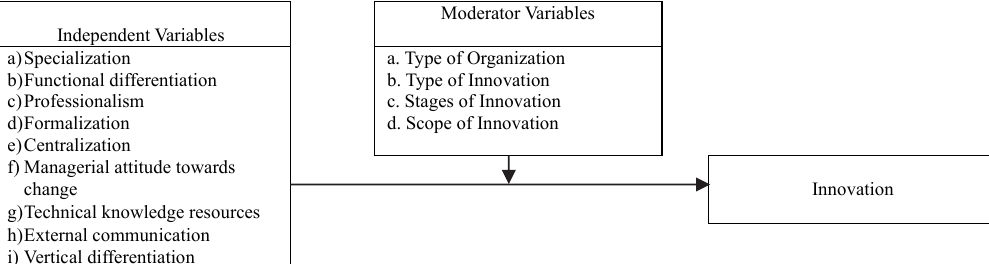
Fig. 2. Moderating variables on relationship of independent variables and innovation (Source: Damanpour